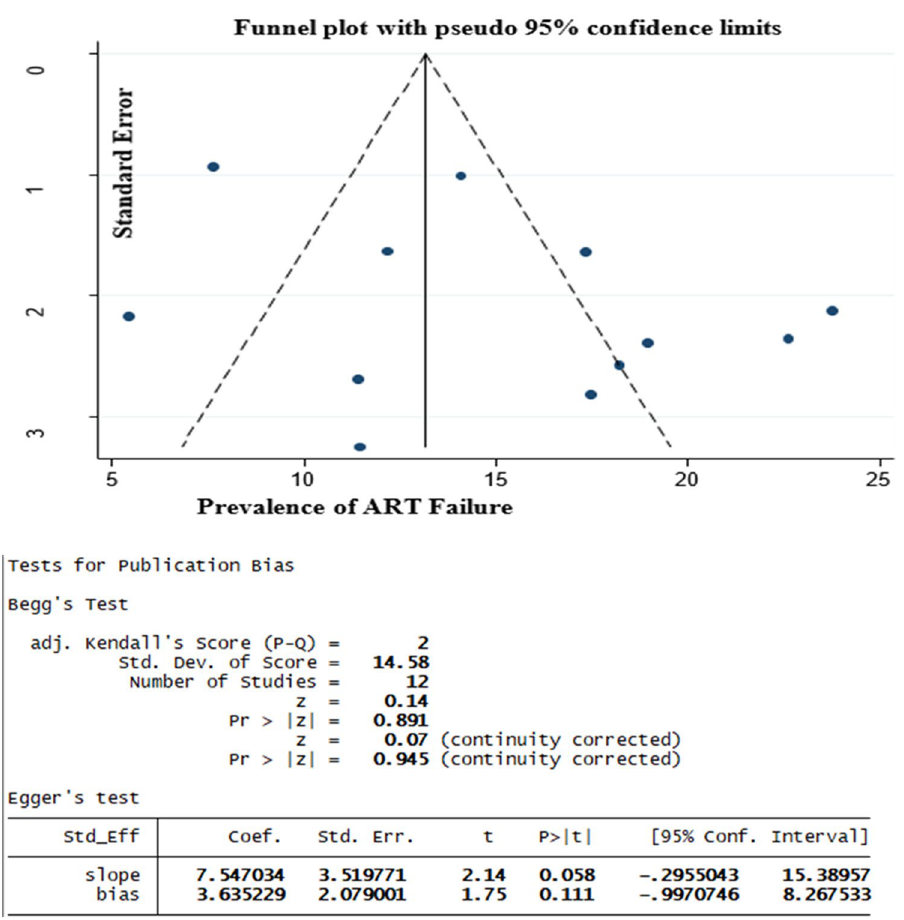
Figure 6. Test of publication bias for prevalence studies by using Begg’s and Egger’s test,